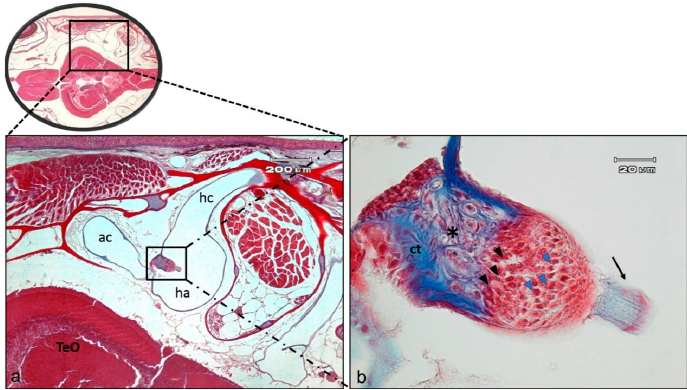
Figure 2. ( a ) Light micrographs (Masson Trichrome with Anylin blue staining) of adult zebrafish head; dorso-ventral view, horizontal section: semicircular horizontal canal (hc) of the inner ear, with its ampulla (ha) containing the crista ampullaris, placed near Optic tectum (TeO), are visible; ac—semicircular anterior canal; ( b ) High magnification of ampullary crest in the horizontal canal: the connective tissue (ct) supports nerve fibers (asterisk). The black arrowheads indicate the supporting cells, blue arrowheads indicate the hair cells, the arrow points to the cupula.